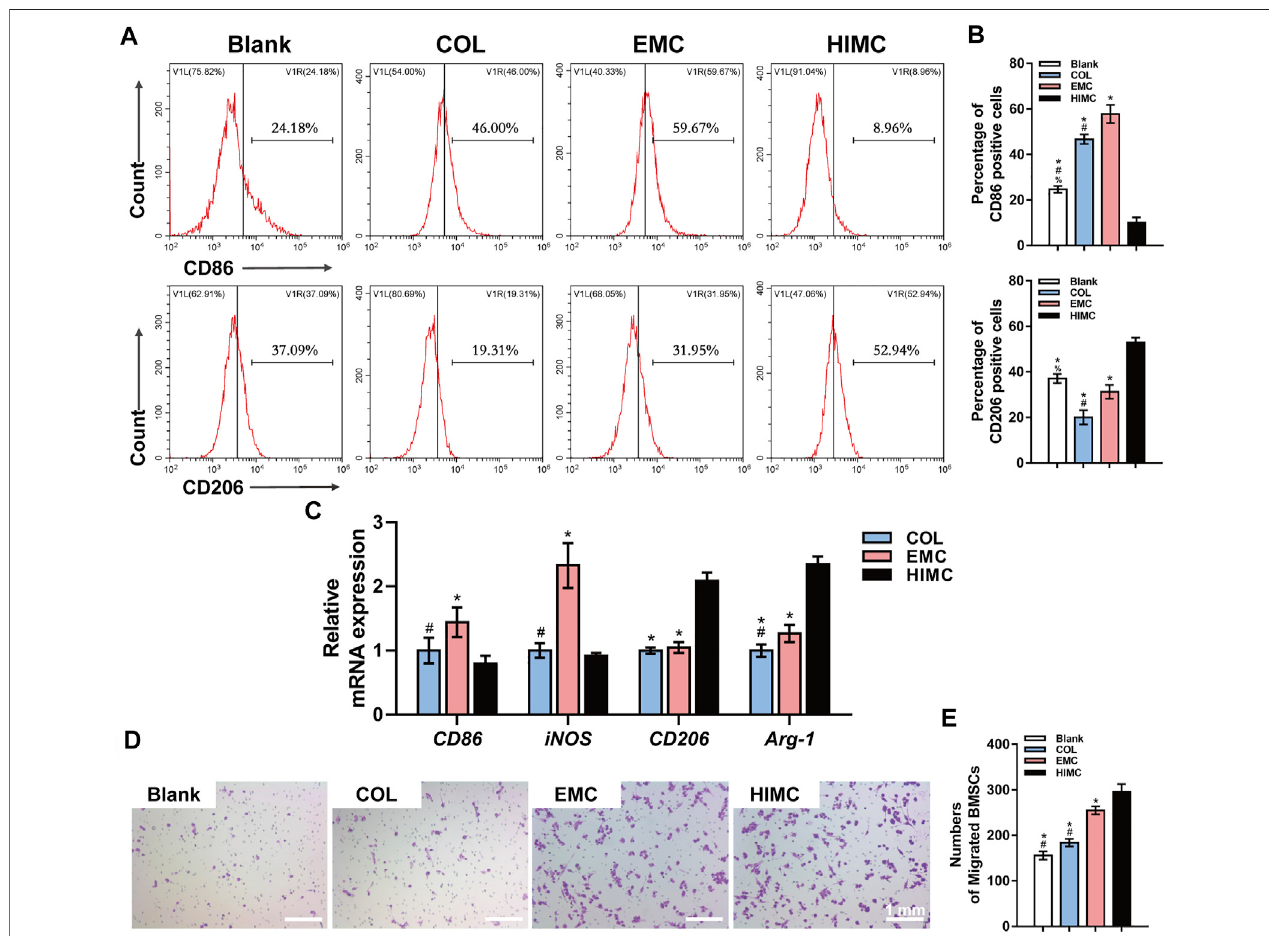
FIGURE 4 | Macrophage polarization and BMSC migration in response to different membranes. (A) Representative peak plots of CD86 + (M1 polarization) and CD206+(M2polarization)macrophageratiosexaminedby fl owcytometry. (B) PercentagesofCD86 + andCD206+cells. (C) mRNAexpressionlevelsofM1polarization genes ( CD86, iNOS ) and M2 ( CD206, Arg-1 ) in macrophages as measured by qRT-PCR. (D) Crystal violet staining of Transwell inserts for detection of BMSC migration inducedbymacrophages. (E) Quanti fi cationofBMSCmigration.Dataareexpressedasmean±SD.Scalebar,1 mm.* p < 0.05vs.HIMCmembrane; # p < 0.05vs. EMC membrane; % p < 0.05 vs. COL